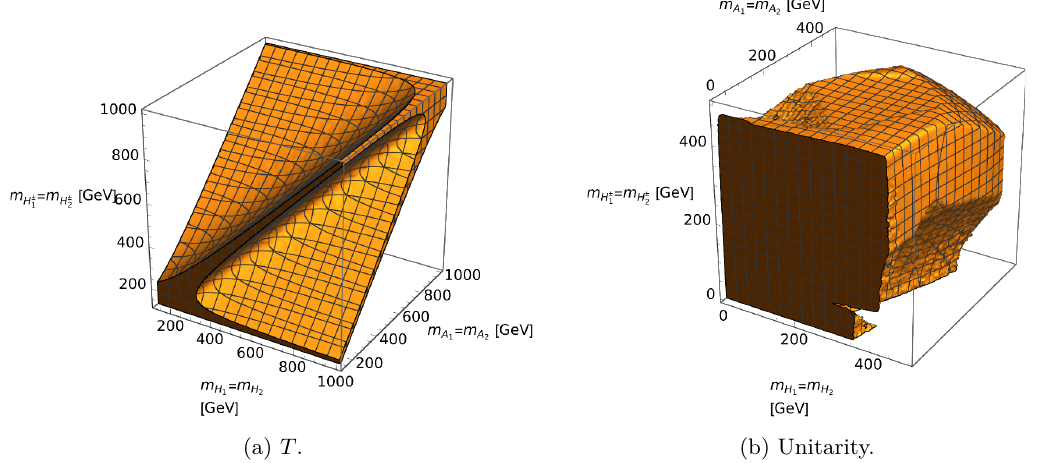
Figure 3. Regions allowed by the T -parameter at 99% level (a) and unitarity (b) for the ( v, v, v ) vacuum in the m H = m H vs. m A = m A vs. m = m space. The 4th free parameter, the H ± 1 H ± 2 1 2 1 2 mass of the SM-like Higgs m h , is set to 125.25 GeV. On the left panel we additionally assume that all masses are larger than m h while on the right one that they are larger than 1 GeV.